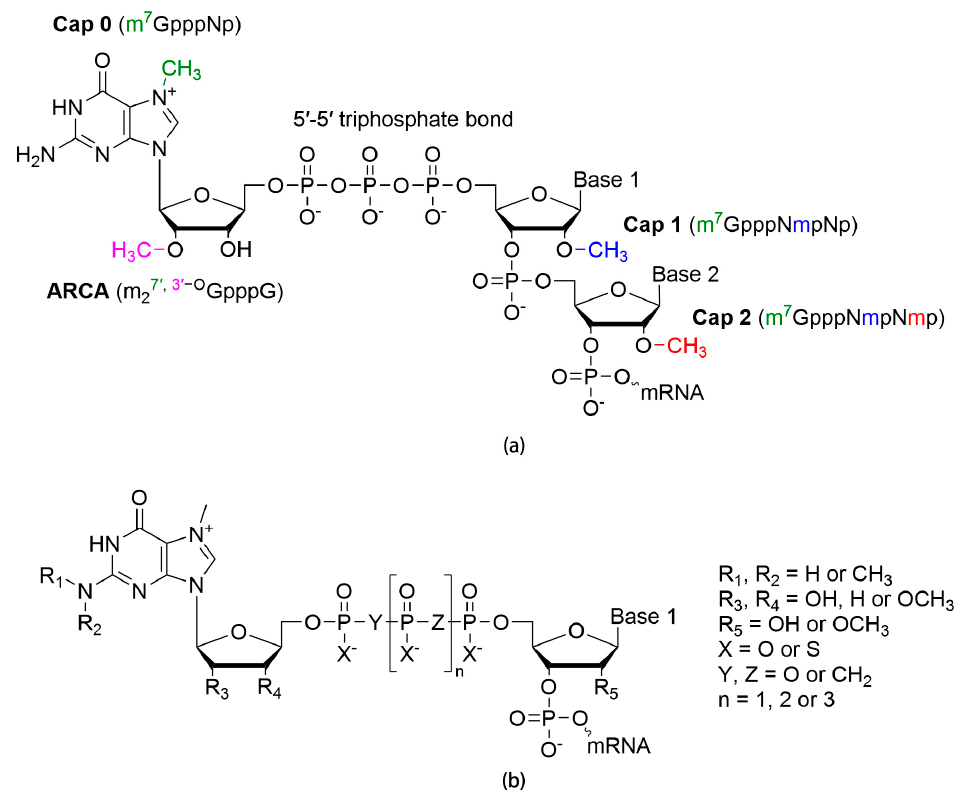
Figure 2. The 5 ′ -cap structures of IVT mRNAs. ( a ) Structure of cap 0, cap 1, cap 2, and ARCA. ( b ) Chemical modifications of 5 ′ -cap analogs.